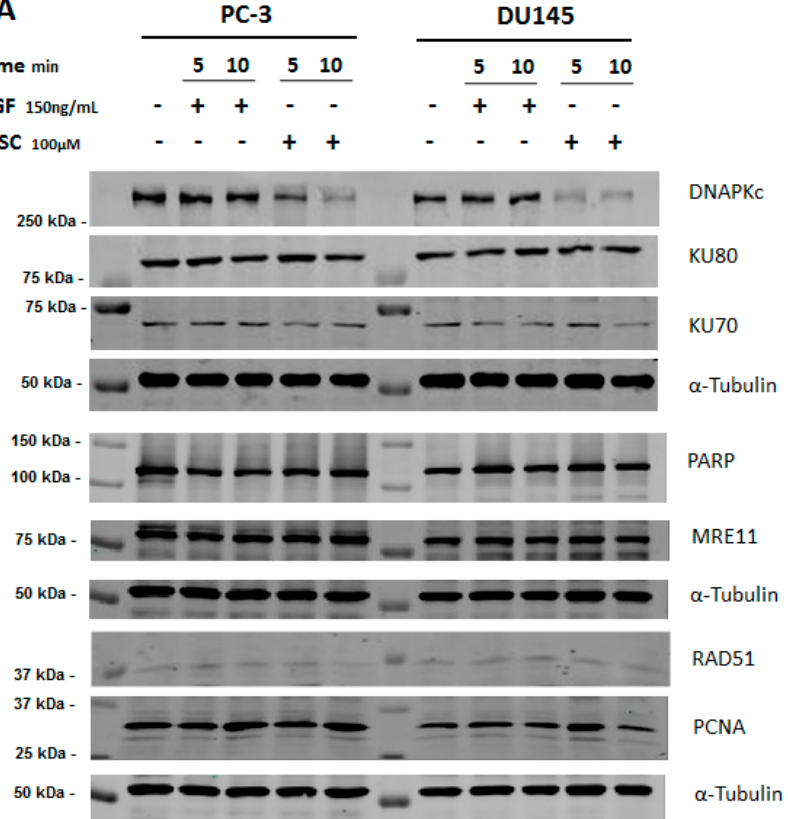
Figure 1. Cont. Figure 1.